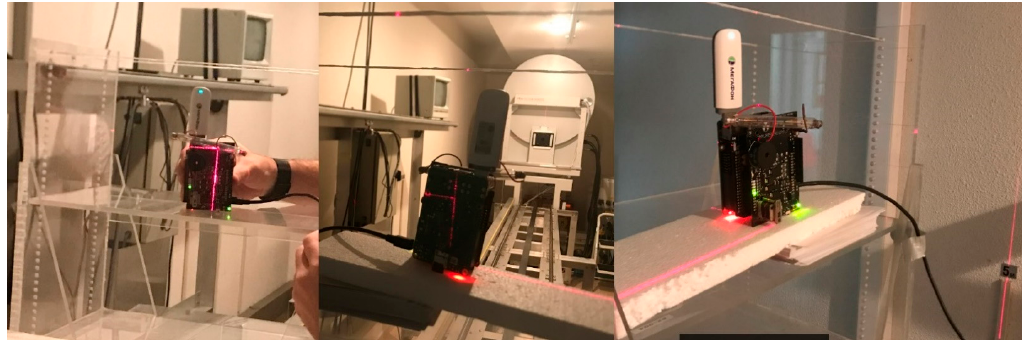
Figure 20. Device verification sequence.